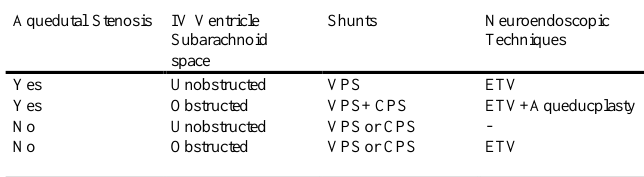
Table 1. Current surgical strategies for Hydrocephalus in Dandy – Walker